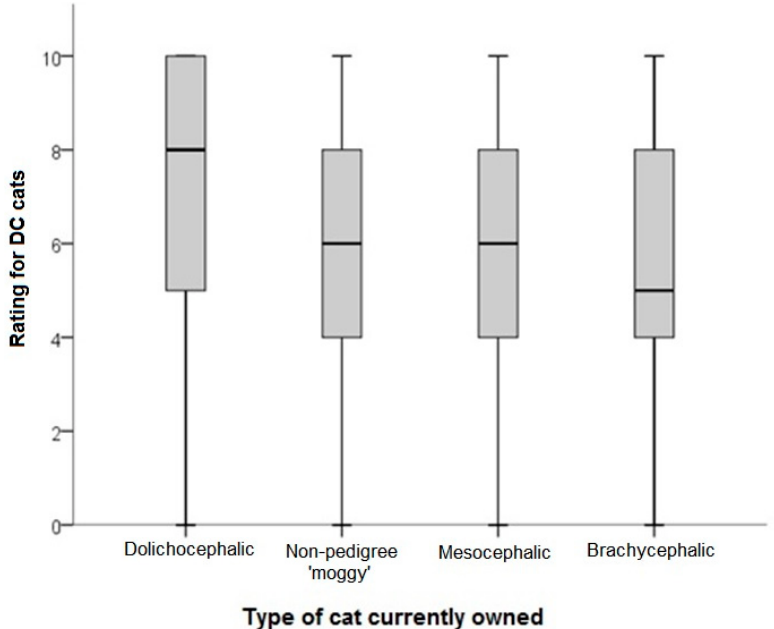
Figure 6. Ratings of liking (0 = I don’t like this cat at all; 10 = This is my favorite kind of cat) for cats identified as having mild to extreme dolichocephaly (DC; n = 4/15 cat images as per Table 1). Ratings were provided by respondents ( n = 1239) to two questionnaires. Comparisons are relative to skull morphology of the oldest cat currently owned, as based on reported breed of oldest owned cat and the associated breed standard.